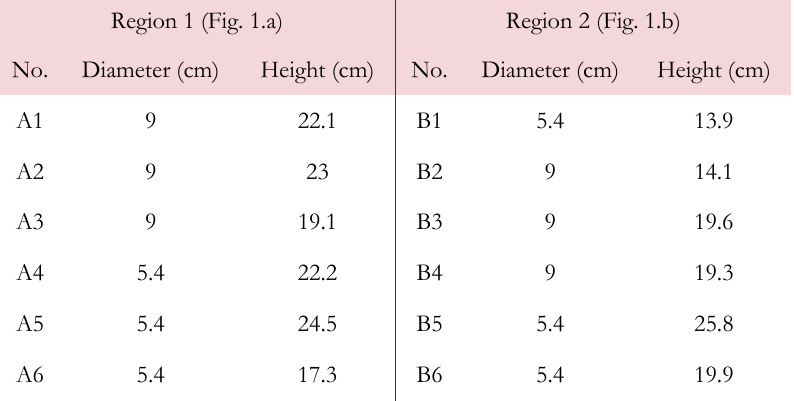
Table 1: The size of core samples for two study regions